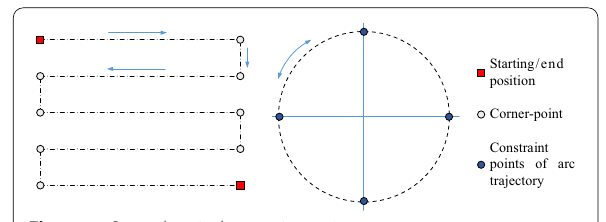
Figure 8 shows the transformation relationship between the starting and ending points of a machining range, where φ x is the difference in the rotation angle around the x -axis of the position of the starting and ending points.